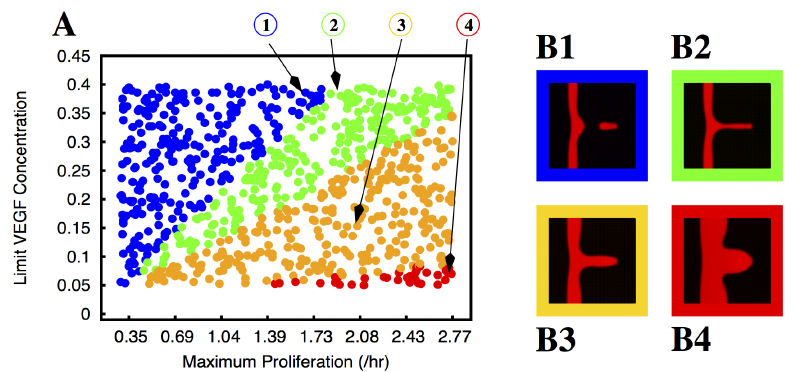
Fig 6. Morphology of the growing sprouts with endothelial cell proliferation dependent VEGF concentration. In plate A we indicate the morphology of the growing sprout (by using different colours) for different values of maximum proliferation ( M P ) and limit VEGF concentration ( L V ). In these simulation the proliferation rate increases linearly with the VEGF concentration until it reaches the value M P at the VEGF concentration L V . The colours indicate the morphology of the observed sprouts for the corresponding parameters: blue dots correspond to situations where the sprout breaks, the green dots correspond to well formed sprouts without appreciable thickening of the parental vessel, the orange dots correspond to well formed sprouts with appreciable thickening of the parental vessel, and the red dots correspond to deformed vessels (triangular sprouts in this case). We observe that the sprout breaks for low proliferation rates, but there is a large region of the parameter space with well formed sprouts. There is however extensive parental vessel thickening. In plates B1, B2, B3 and B4 we plot examples of the morphologies observed (the color of the border in these plates follows the same code as in plate A). The parameters used to obtain the morphologies depicted in B1, B2, B3 and B4 are indicated by arrows in plate